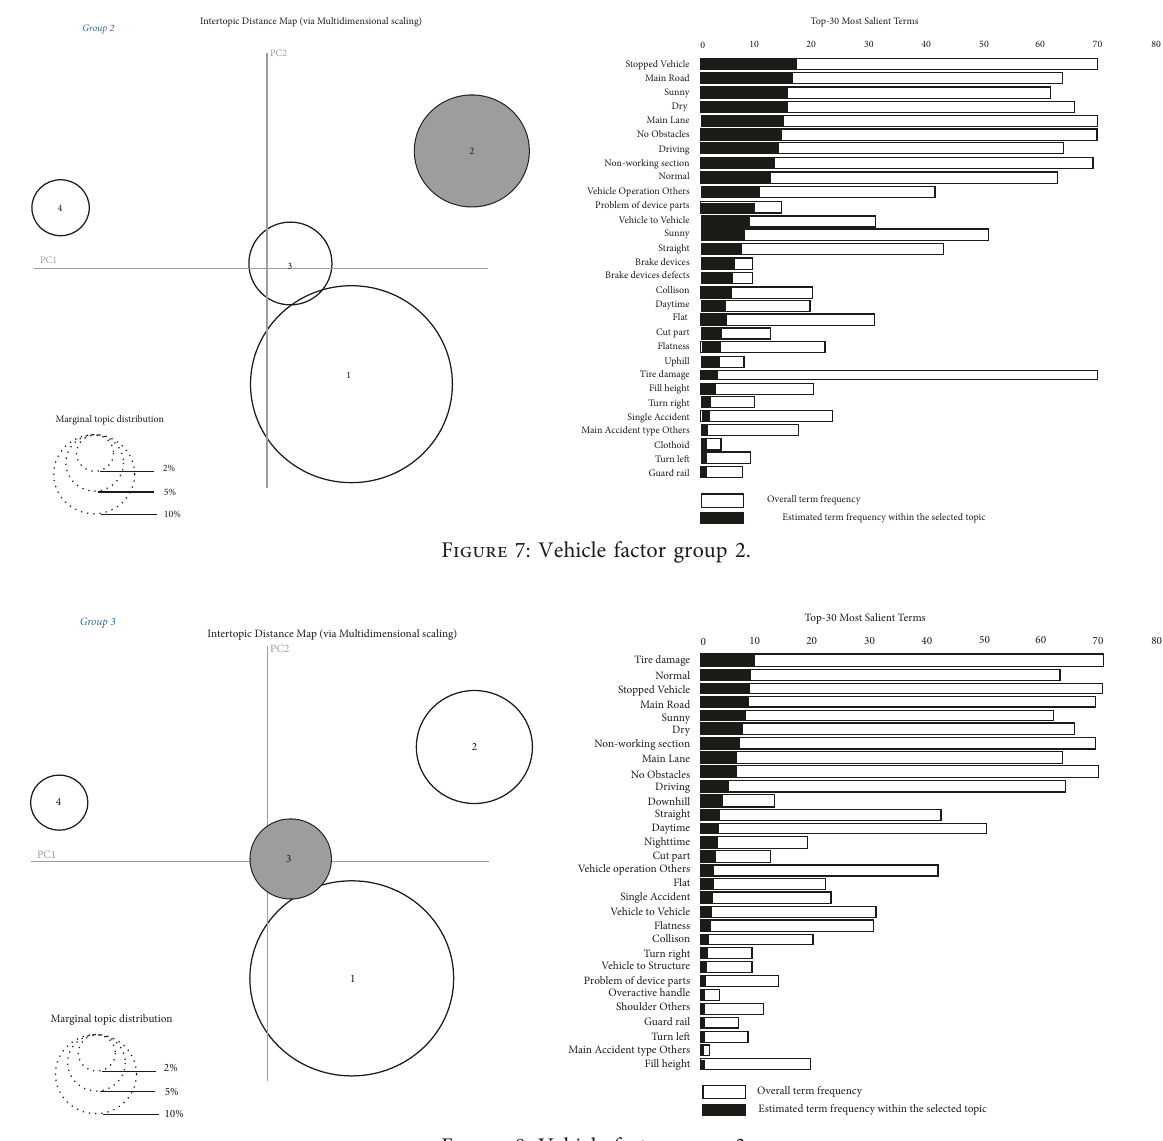
Figure 8: Vehicle factor group